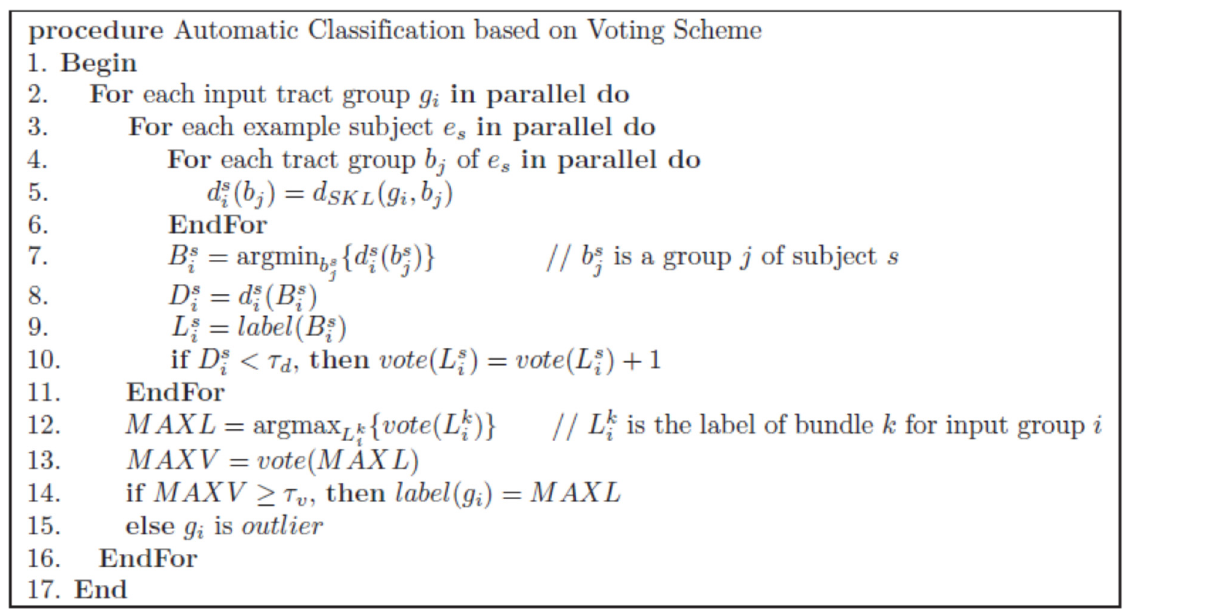
Fig 4. Skeleton of our automatic classification algorithm. The skeleton of the voting algorithm to determine the label of an input